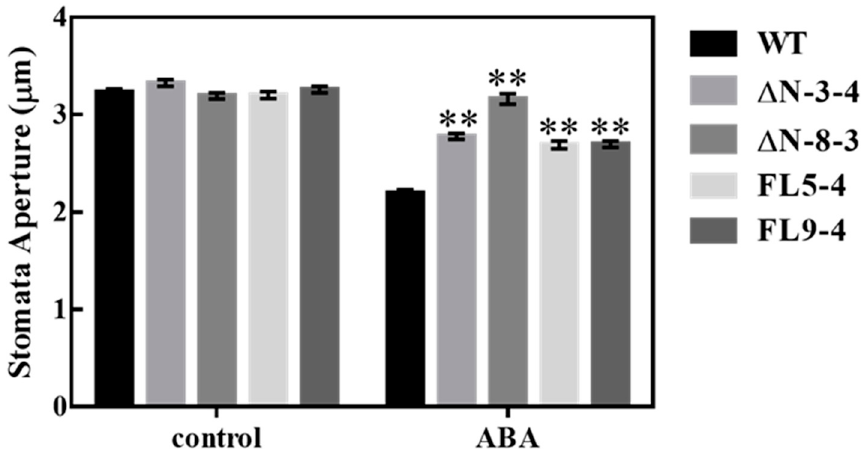
Figure 4. Epidermal strips of wild-type (WT) and all RLCK311 over-expressing lines were first incubated in stomatal opening buffer under the light and then treated with 0 or 50 µM ABA for 20 min, and stomatal pore area was microscopically assessed. Values plots of > 700 measurements (stomata). Asterisks represent significant differences between transgenic lines and wild-type within a treatment by the Dunnet test (*, p < 0.05 and **, p < 0.01).